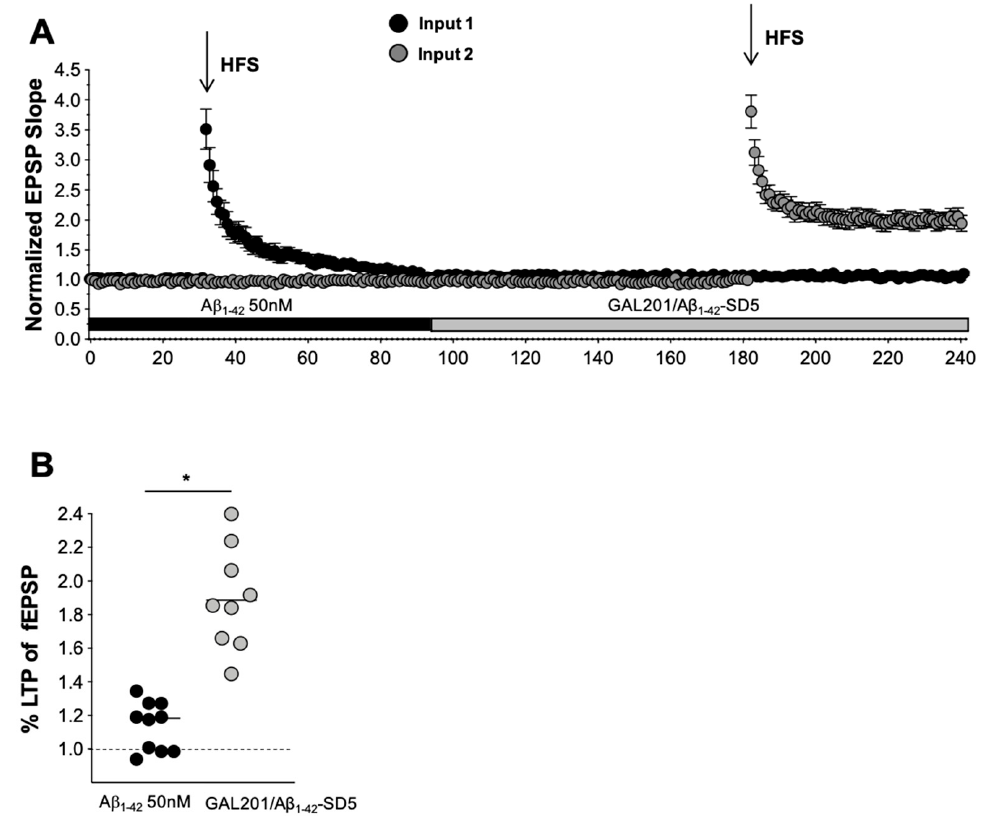
Figure 8. Reversal of an already established synaptotoxic effect caused by A β 1-42 . The GAL-201/A β 1-42 -SD5 solution was capable of detoxifying an already established neurotoxic process. ( A , B ) LTP was first induced in the presence of 50 nM A β 1-42 in the first input then after the application of the GAL-201/A β 1-42 -SD5 solution in the second input. ( A ) Pooled data of the full-length two-input experiments. After slices were incubated with GAL-201/A β 1-42 -SD5 solution, LTP completely recovered. ( B ) Scatter dot plot summarizing the experiments for GAL-201 when the last 50 to 60 min after HFS were analyzed. (* p < 0.05).